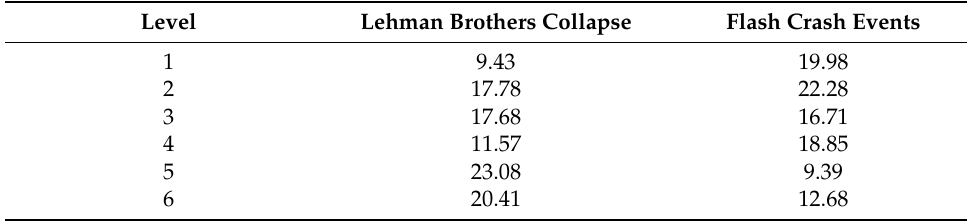
Table 6. Power spectra for UTX stock market data.